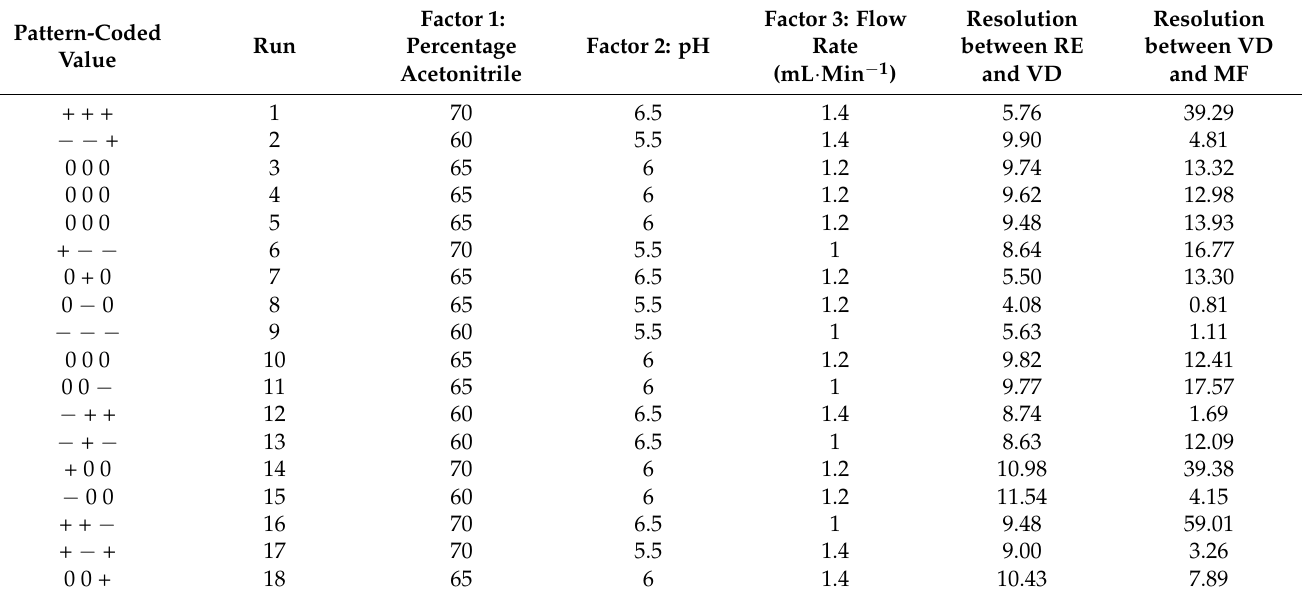
Table 1. Seventeen experiments suggested by face-centered CCD for the optimization of chromato- graphic